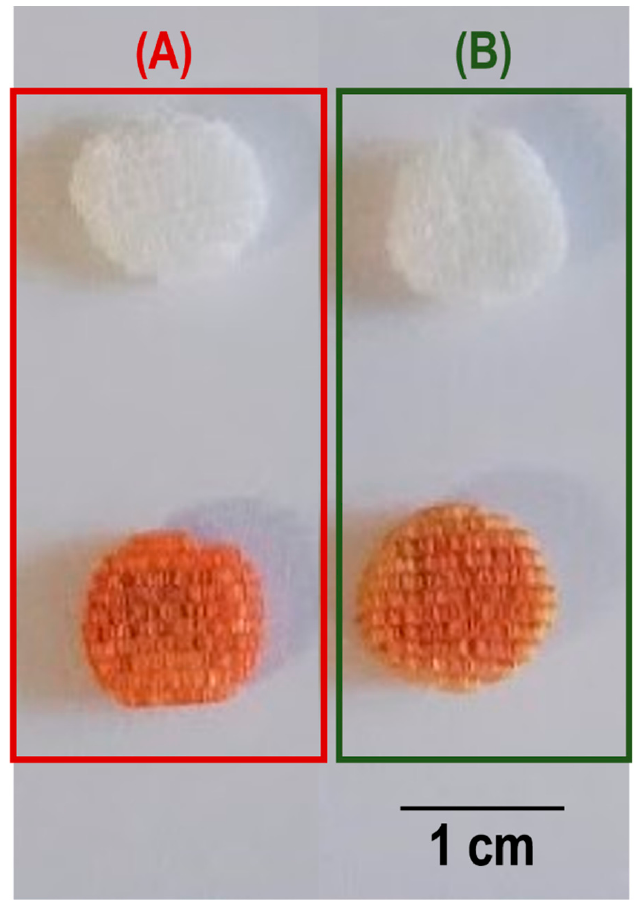
Figure 3. BCP scaffolds coated with different polymers (PCL ( A ) and PEU ( B )—white), and further loaded with RFP (burnt orange).